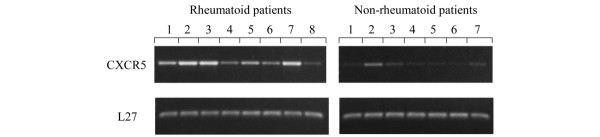
RT-PCR on rheumatoid arthritis and non-rheumatoid arthritis synovial tissue. CXCR5 RT-PCR products were separated on 0.8% agarose gels and stained with ethidium bromide. The reactions were performed on the individual RNA samples that were applied to the microarray membranes. The ribosomal RNA L27 was employed to normalize the amount of RNA used in each reaction.